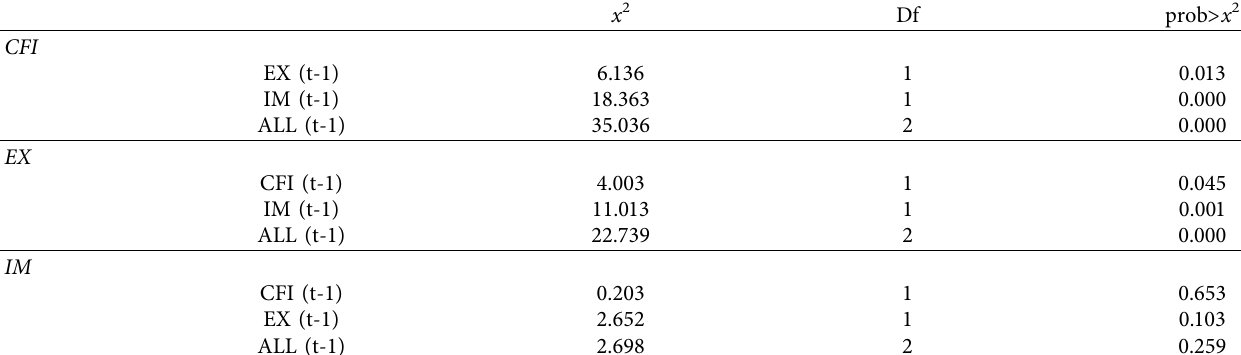
Figure 3: Causal relationships. Table 5: Wald test of Granger causality.